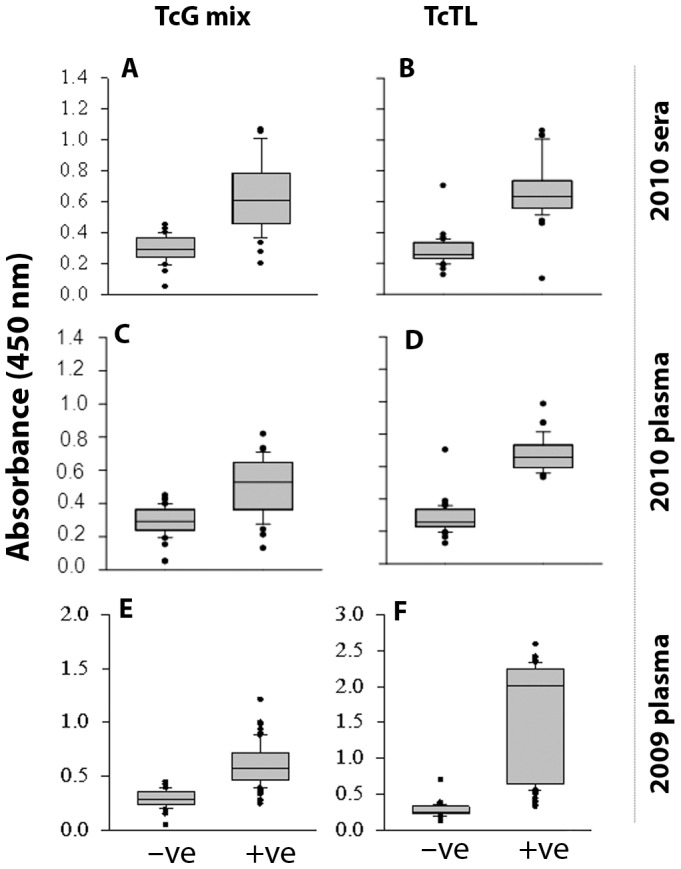
TcGmix-based ELISA provides superior efficacy in identifying exposure to T. cruzi infection among inhabitants of Salta Argentina.Sera (A&B) and plasma (C–F) samples, characterized as seropositive (+ve) and seronegative (−ve) by conventional approaches, were submitted to multiplex ELISA using the mixture of recombinant TcG1, TcG2 and TcG4 proteins for capturing the antigen-specific antibody response (A,C,E). Shown are the antibody response captured using the T. cruzi trypomastigote lysate (TcTL) as a source of crude antigen (B,D,F) for comparison purpose.